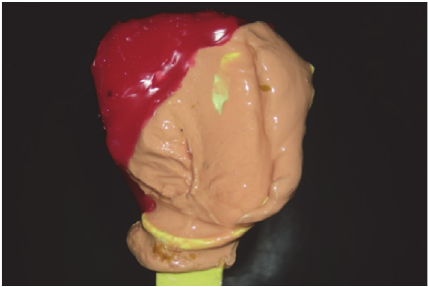
Figure 4: Primary impression recorded with irreversible hydro- colloid using modified perforated plastic-stock-tray. Remaining portion of defect area was built up with modelling wax.